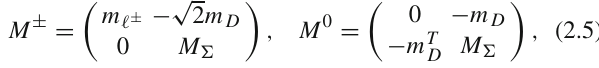
neutral fermion states, M 0 in ( ν, (cid:2) 0 ) basis, are expressed as